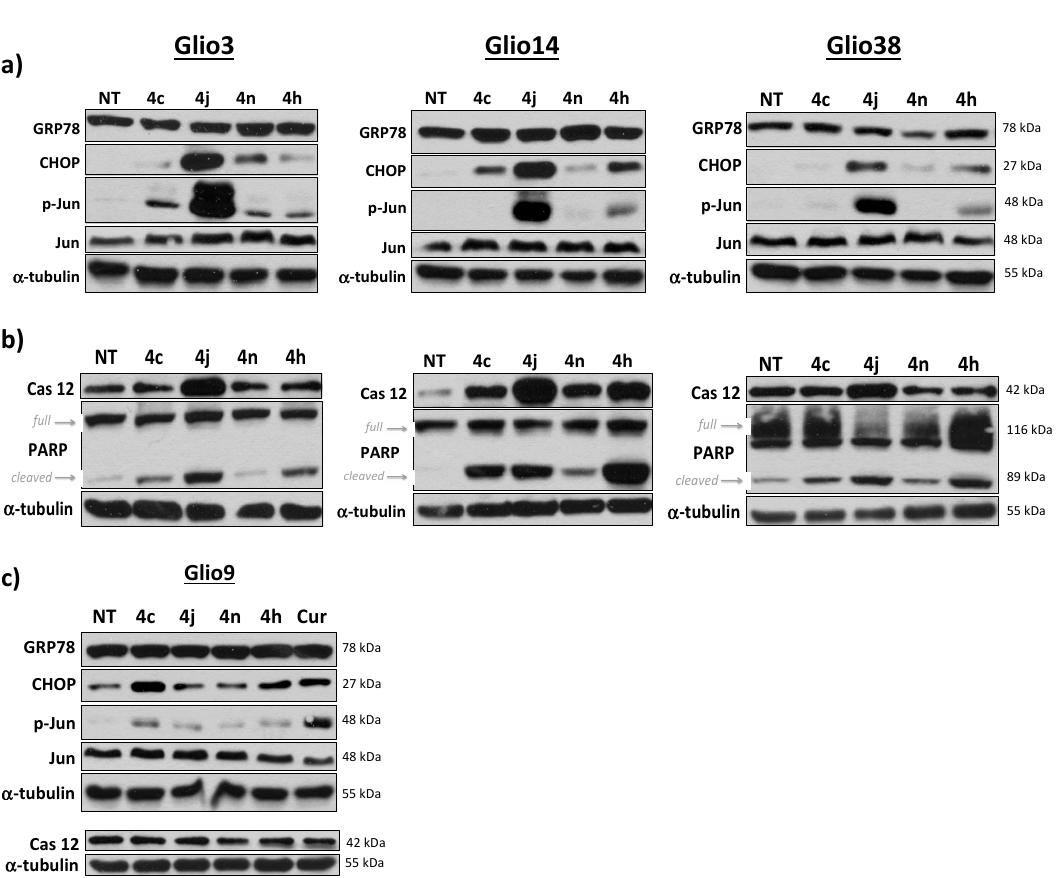
Figure 7. Western blot analysis indicates that 4j induces robust ER stress and UPR in neurosphere cells. Glio3, Glio9, Glio14 and Glio38 were treated with 5 µ M of bis-chalcones 4c, 4h, 4j, and 4n for 8 or 24 h and subjected to Western blot analysis. Levels of GRP78, CHOP, p-jun, jun, were examined at 8 h. Levels of caspase 12 and cleaved PARP were examined at 24 h. α -tubulin serves as a loading control. ( a ) levels of ER stress/UPR markers at eight hour in the neurosphere cell lines; ( b ) levels of apoptosis indicators at 24 h in the neurosphere cell lines; ( c ) levels of ER stress/UPR markers in the adherent Glio9 cell line.